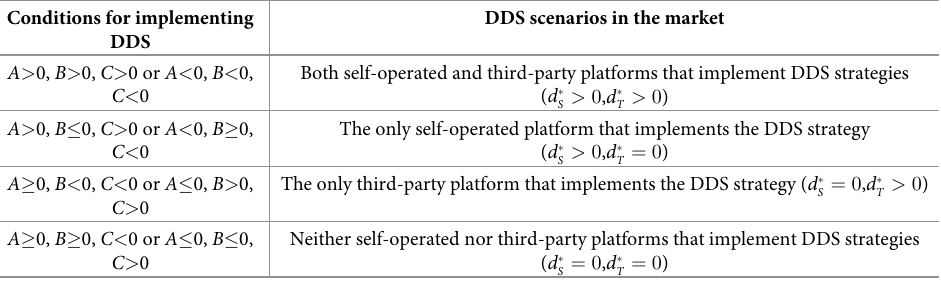
Table 2. DDS scenarios and corresponding conditions. Conditions for implementing DDS